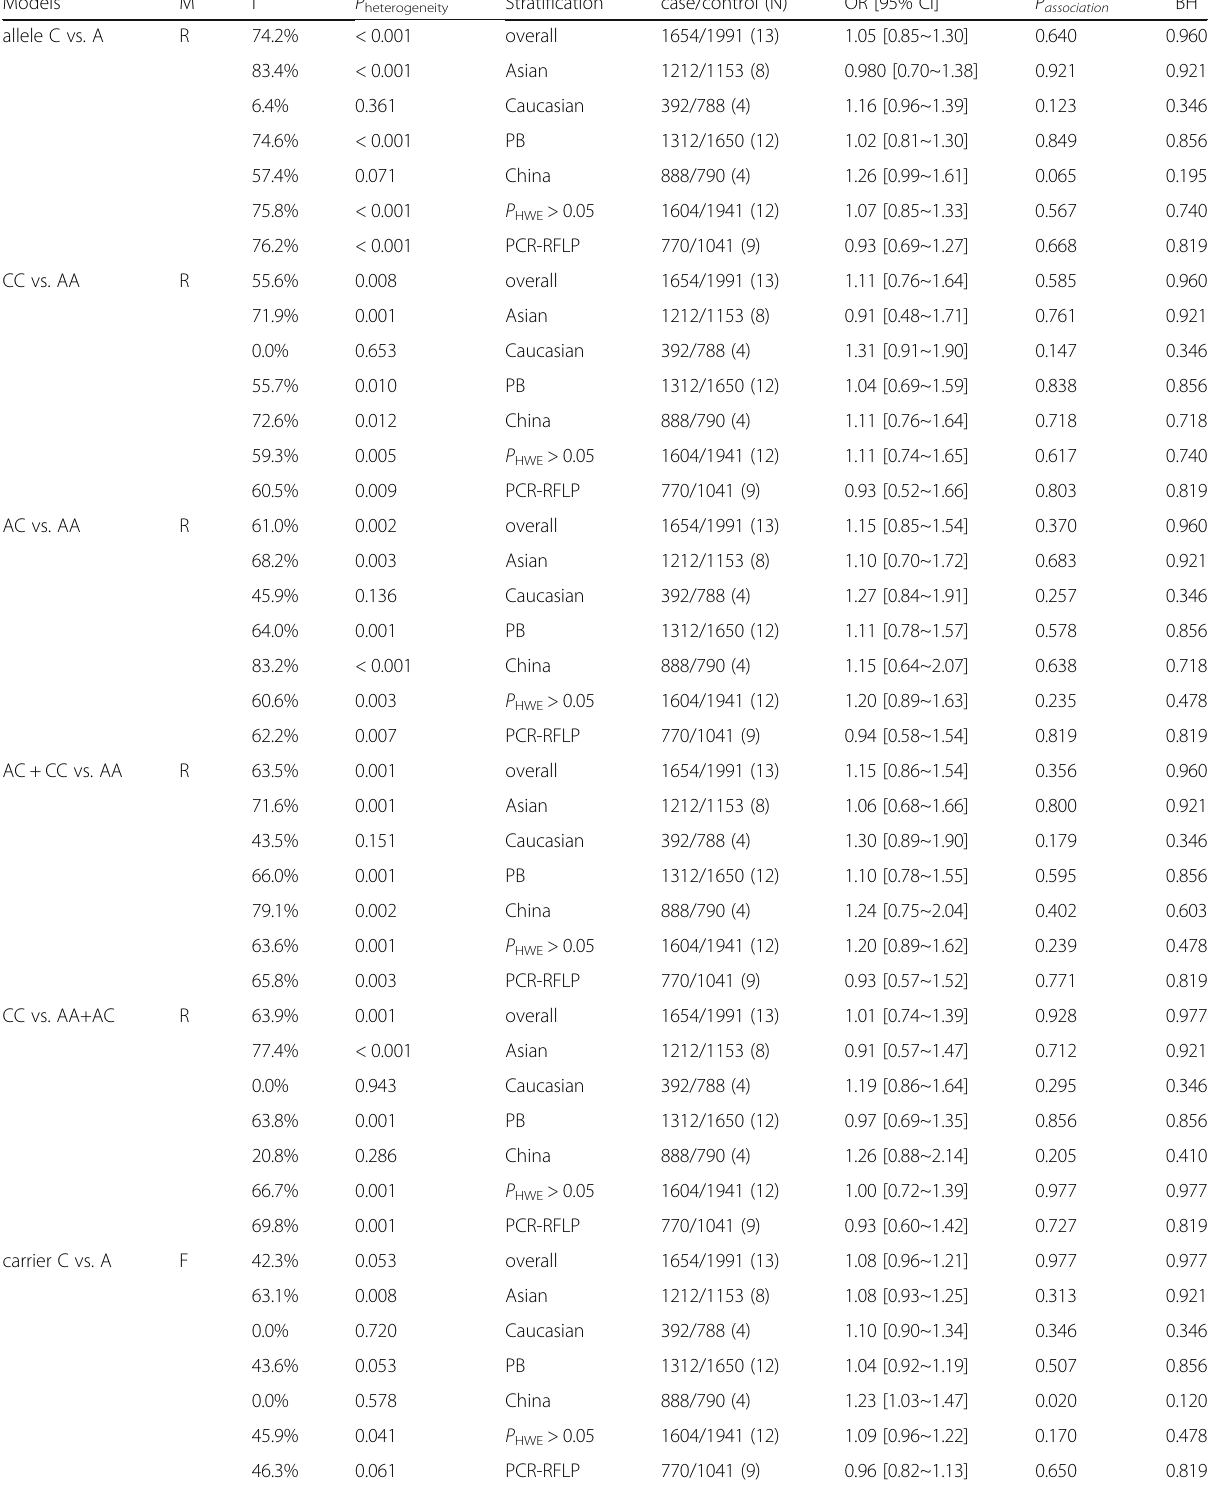
Table 2 Pooled analyses of the association between VDR rs7975232 polymorphism and susceptibility to psoriasis